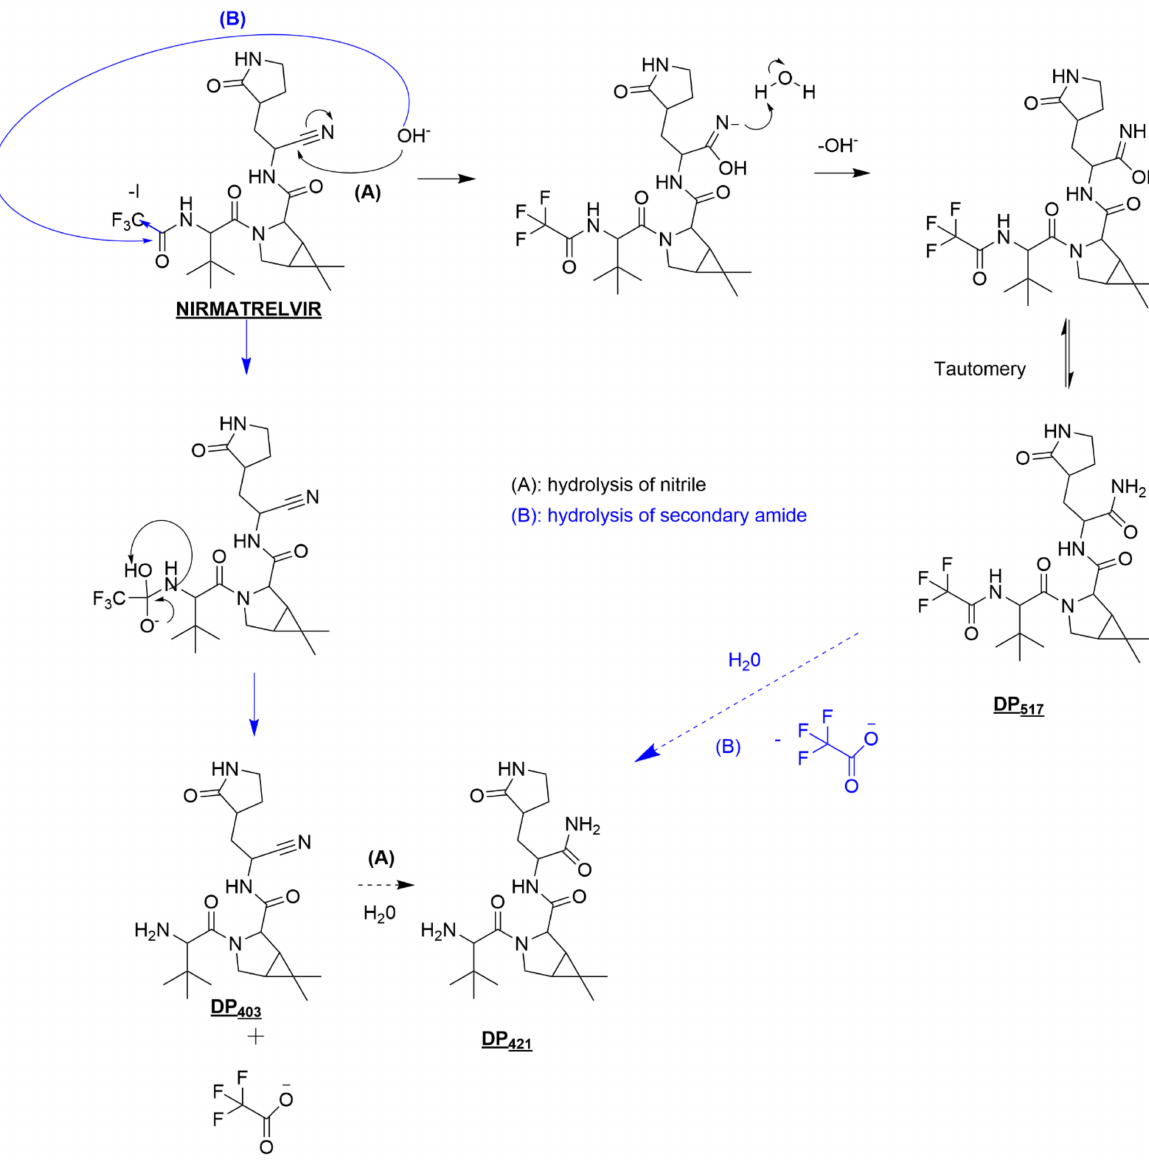
Figure 6. Proposed nirmatrelvir’s degradation pathways under basic